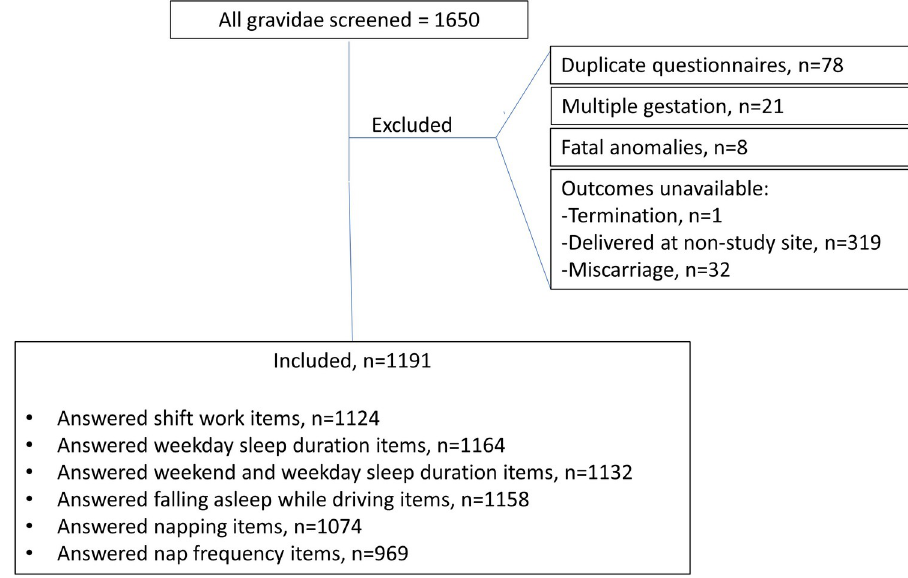
Fig 1. Gravidae included for analysis. Of 1650 completed questionnaires, outcomes were available for 1191 participants. The number included in each analysis is also shown.